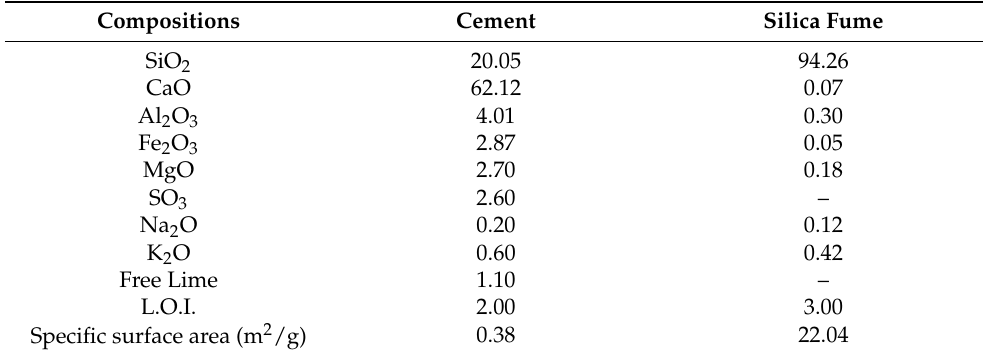
Table 2. Chemical compositions of cement and silica fume (%).